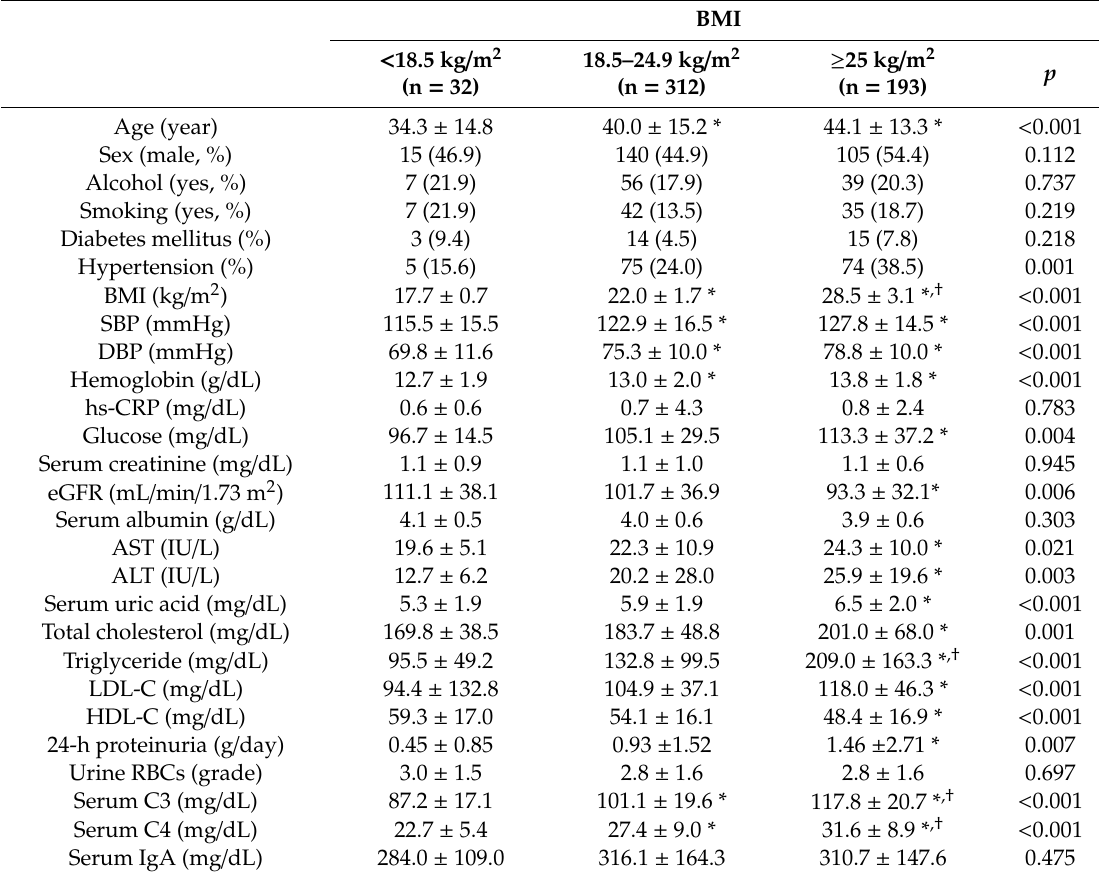
Table 1. Baseline clinical variables of the three BMI groups at the time of renal